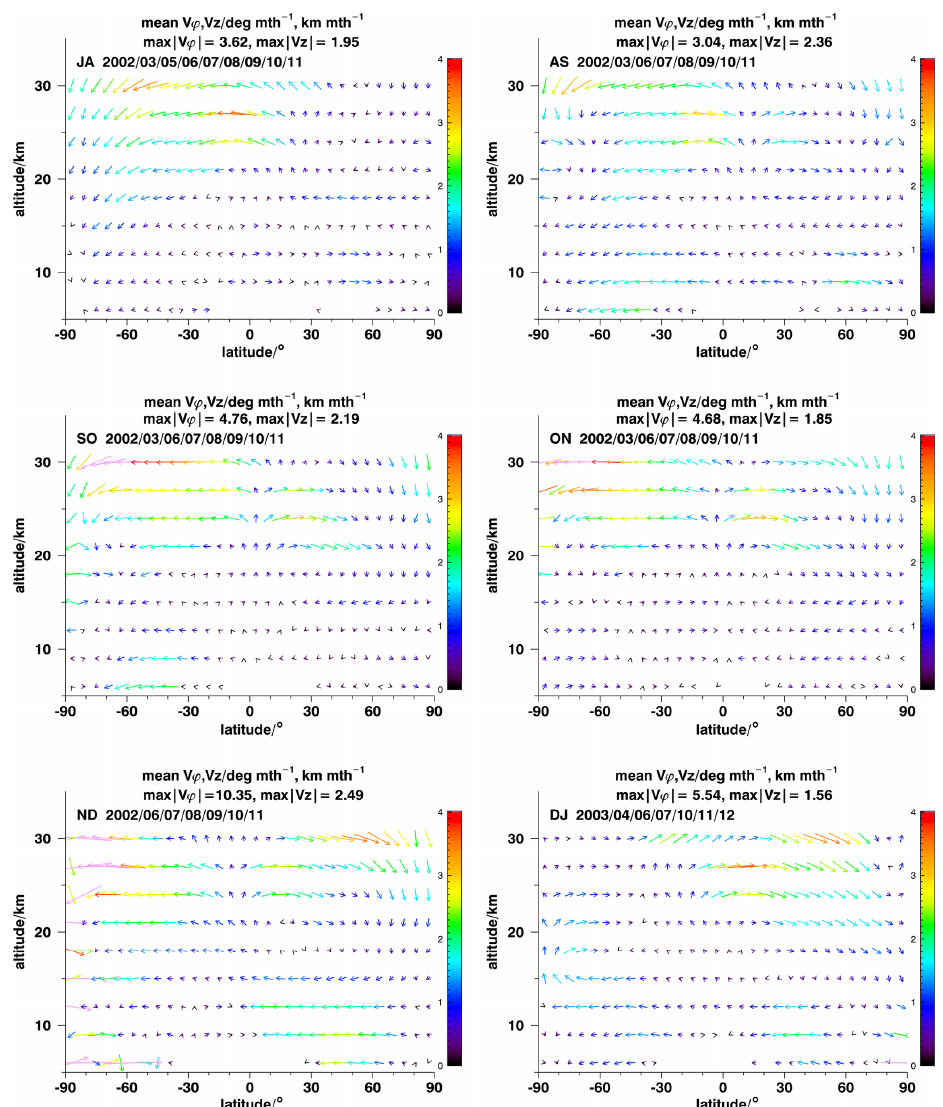
Figure 4. Same as Fig. 2 but for altitudes of up to 30km